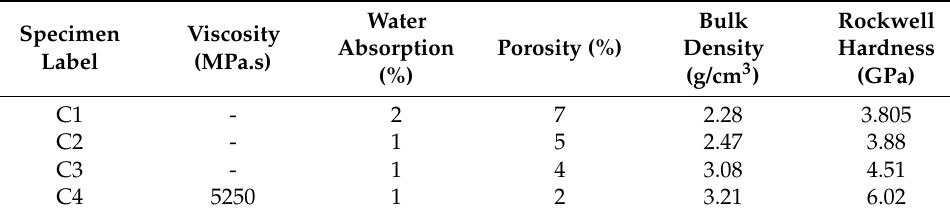
Table 12. The results of viscosity and mechanical properties at different curing times.